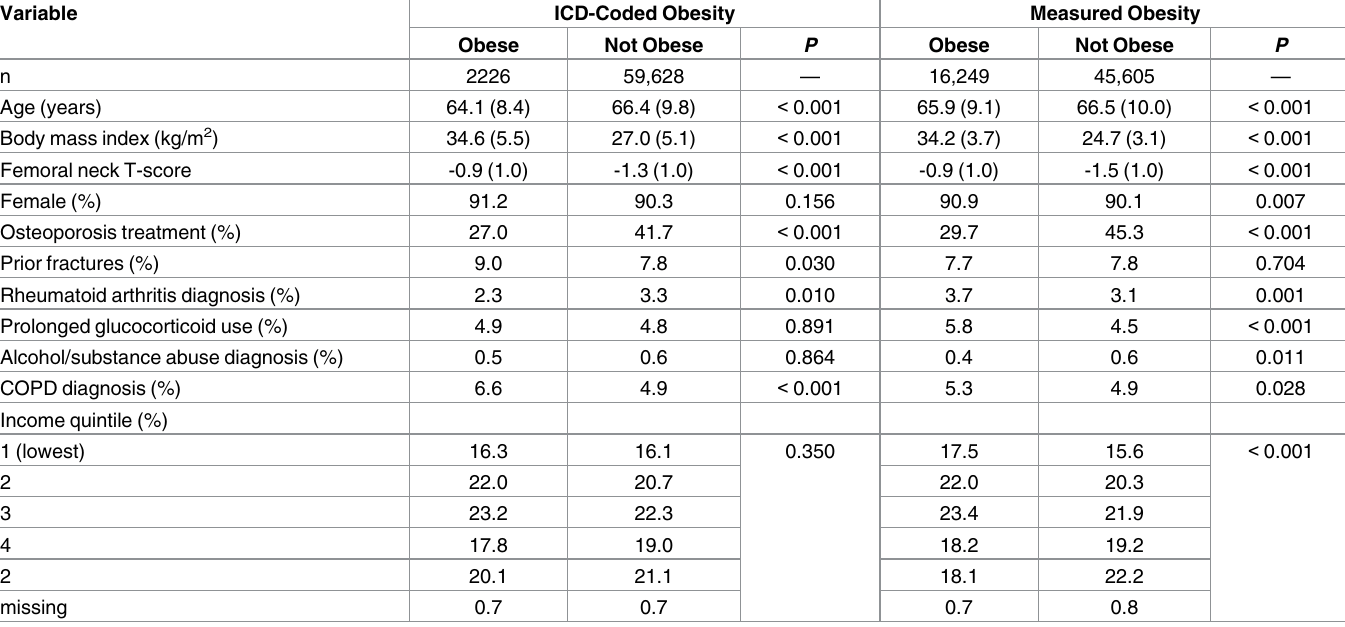
Table 1. Descriptivecharacteristics of cohort stratified by ICD-coded obesity and by